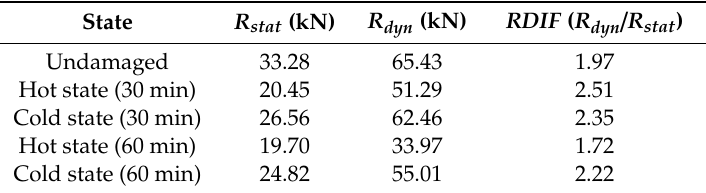
Figure 14. Dynamic analysis—reaction-displacement curves. Table 2. Summary peak reactions for static and dynamic